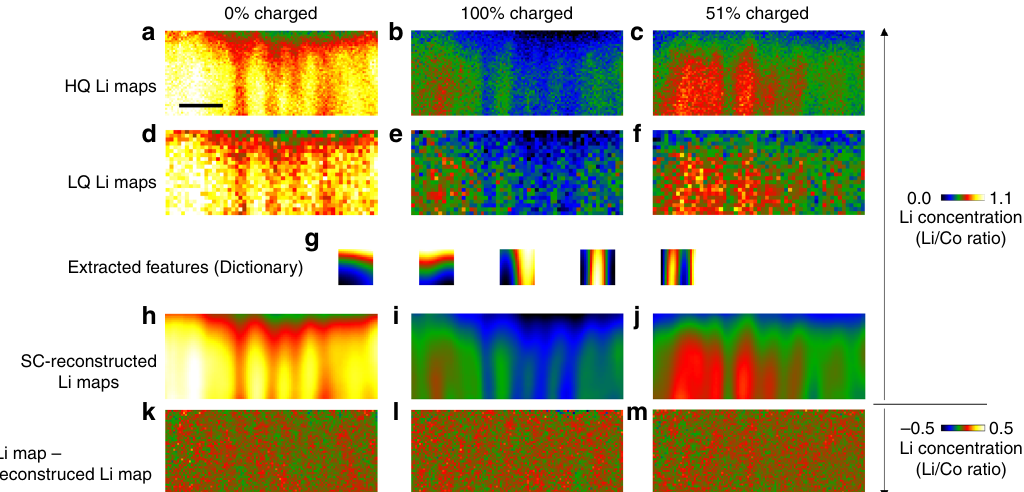
Fig. 3 Denoising and super-resolution of the Li maps by SC. a – c High-quality (HQ) Li maps of the cathode fi lm in the 0% charged, 100% charged, and 51% discharged states, respectively. These images were acquired from the SIs with a high dwell time of 0.04 s/pixel and high resolution of 110 × 45 pixels. d – f Low-quality (LQ) Li maps of the same region and states as a – c . The dwell time and resolution were a quarter of those used for the HQ Li maps ( a – c ). g Extracted morphological features (the so-called dictionary) of the Li distribution. h – j Denoised and super-resolved Li maps obtained from the LQ Li maps ( d – f ) by SC. k – m Residuals between the HQ ( a – c ) and SC-reconstructed ( h – j ) Li maps. Note that the HQ Li maps obtained in the same state as the test images were not used as the training images to avoid over fi tting, that is, only the HQ Li maps in the 100% charged and 51% discharged states (Fig. 3b, c) were used as the training images for reconstruction of the LQ Li map in the 0% charged state (Fig. 3d). The scale bar in a is 100 nm.